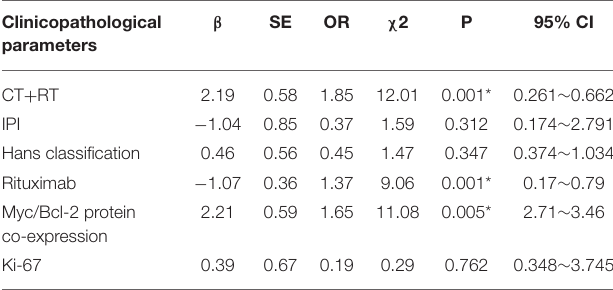
TABLE 3 | Multivariate analysis and regression analysis of COX model affecting the prognosis of patients with primary thyroid DLBCL. Clinicopathological